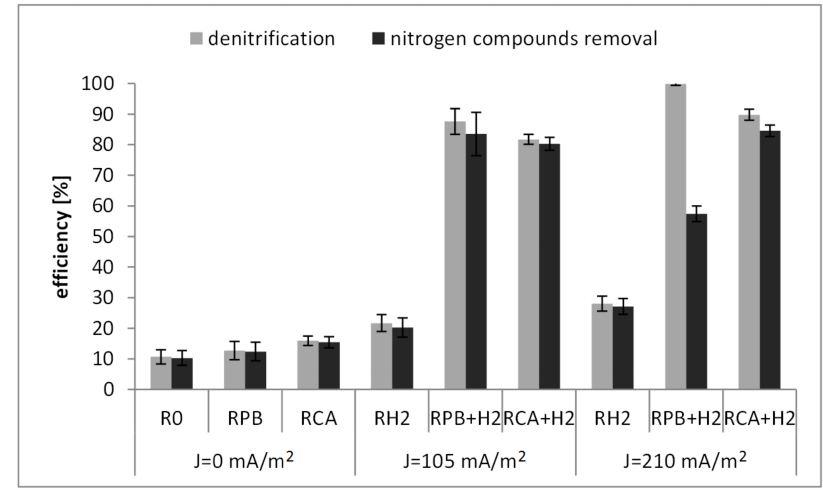
Figure 3. The efficiency of denitrification and nitrogen compound removal: R 0 —control reactor, without an electric current flow and without an external carbon source; R PB —reactor without an electric current flow and with a potassium bicarbonate dosage; R CA —reactor without an electric current